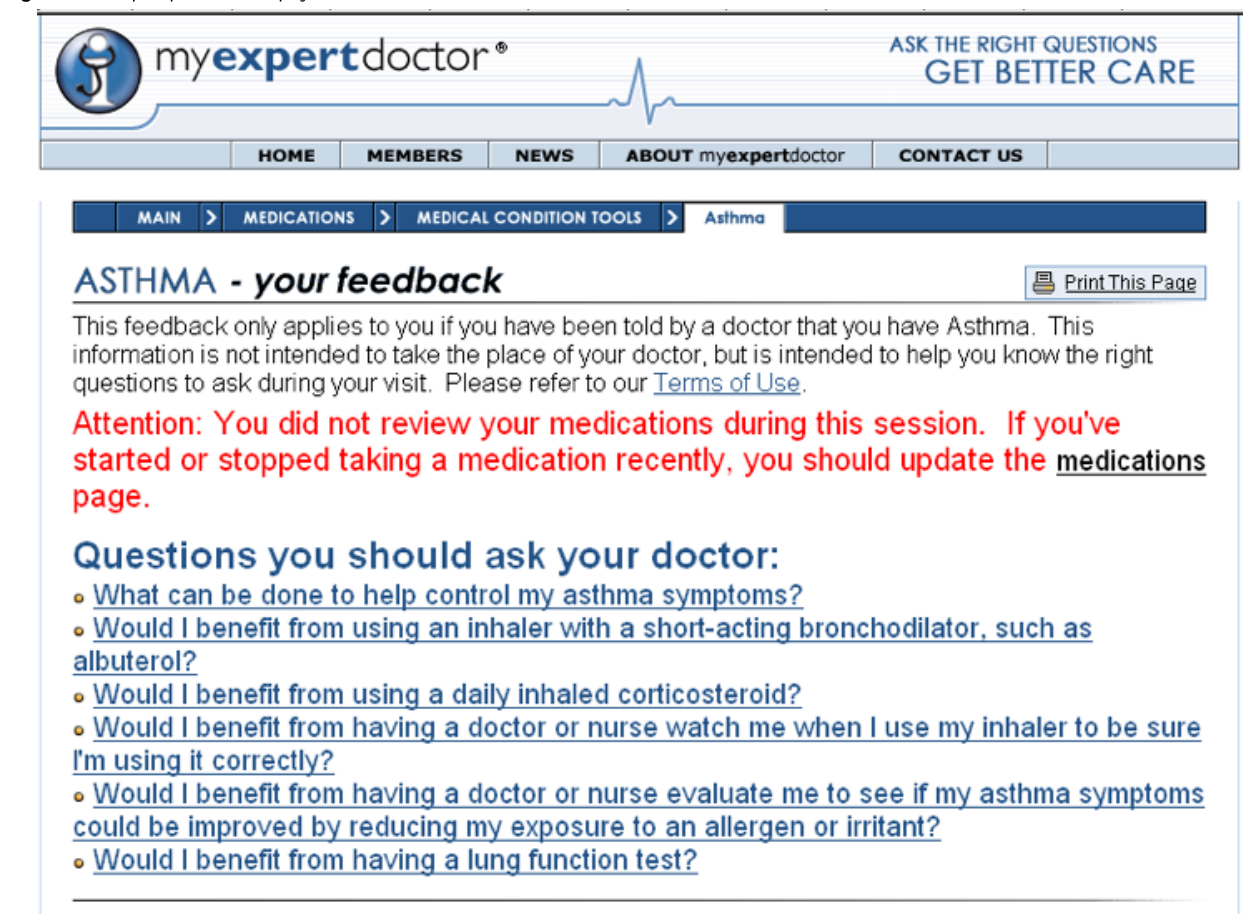
Figure 1. Sample questions for physician and tailored